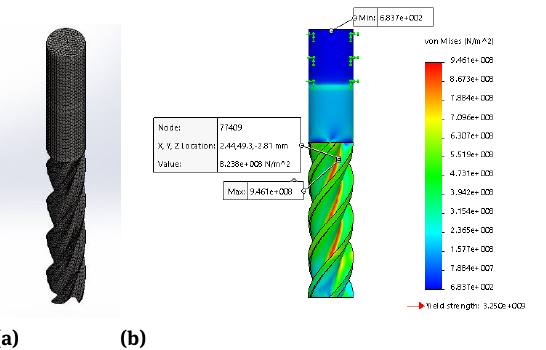
Figure 12: (a) Meshing, (b) Stress distribution when a a was 16 mm